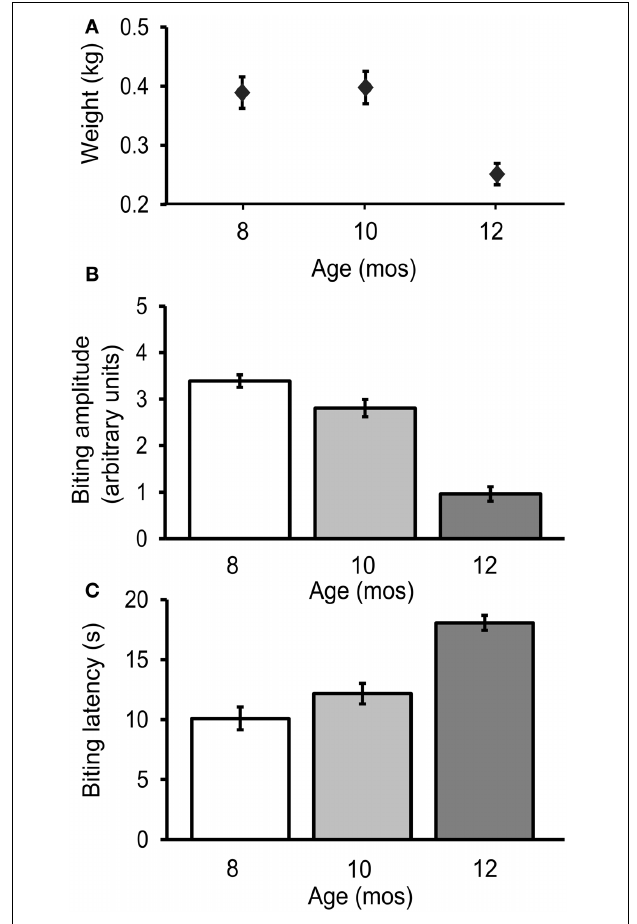
FIGURE 3 | The biting response declined during aging. (A) Weight decreased significantly with age [ p ≤ 0 . 01, F (2 , 98) = 7 . 1, repeated measures ANOVA]. (B) Biting amplitude decreased significantly with age [ p = 0 . 001, F (2 , 98) = 9 . 3] (C) The latency between stimulus contact to the lips and first bite increased significantly with age [ p = 0 . 0001, F (2 , 98) = 21 . 2; n =